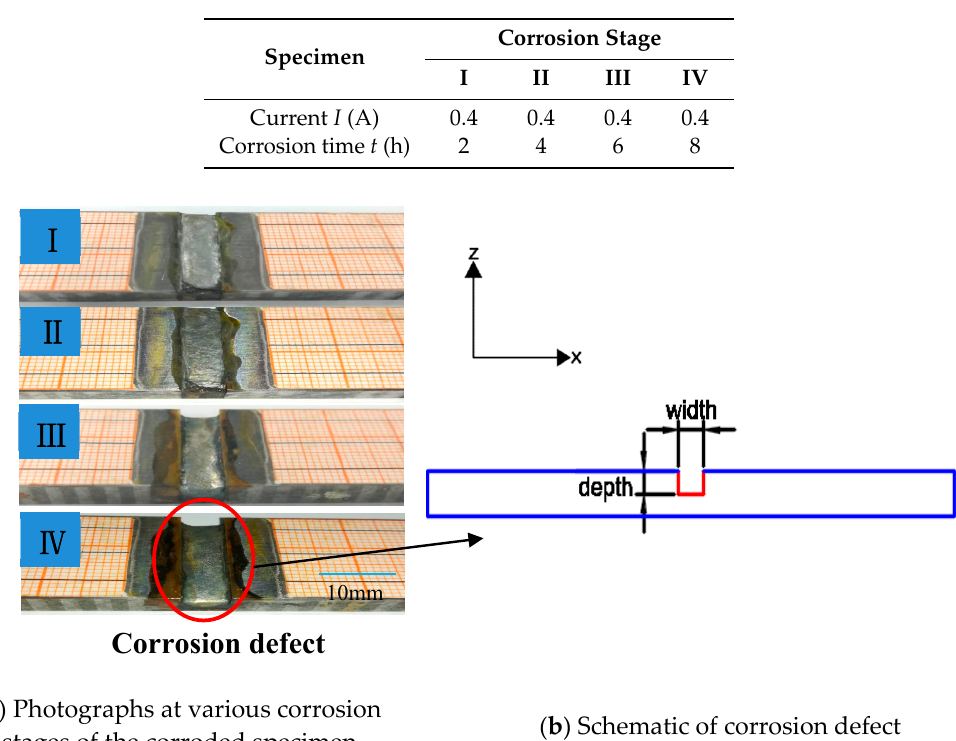
Table 2. Corrosion at different stages.